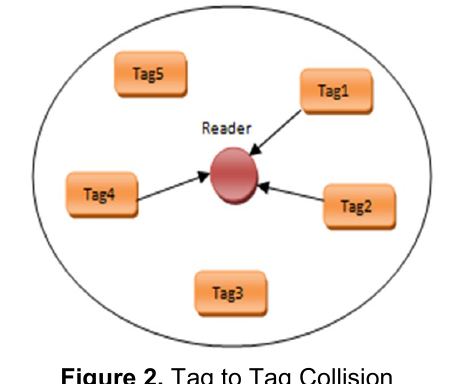
Figure 2. Tag to Tag